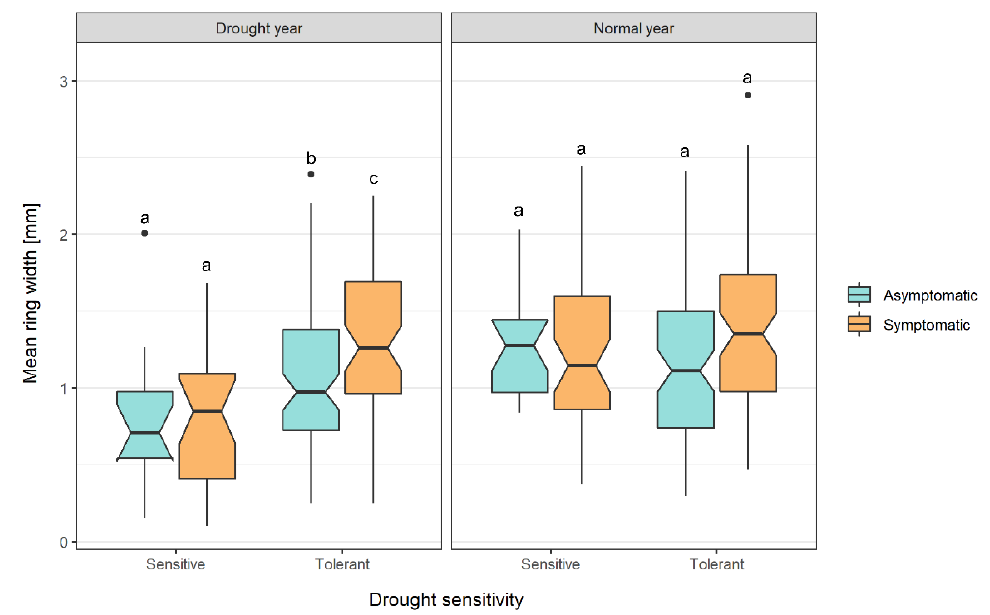
Figure 3. Boxplots of the mean ring width [mm] in climatic drought and normal years preceding the symptomatic expression according to drought sensitivity (drought-tolerant and drought-sensitive) and the symptomatic response of the specimens (asymptomatic and FDp-free (cyan) or symptomatic and FDp-infected (orange)). The letters indicate significant differences among the four categories per year type (Kruskal–Wallis paired test, p < 0.05); for the number of observations: see Table 2. Phloem anomalies were detected in all of the symptomatic and FDp-infected samples, while among the asymptomatic samples, only two out of twenty-six grapevines showed a slight disarrangement (Table 3). Drought sensitivity and the growing sector had no signifi- cant effect on the phloem anomalies either for the asymptomatic or for the symptomatic samples (Chi-Square test, p > Table 3. Number of samples with phloem anomalies according to the four main categories of asymptomatic drought-tolerant (A_dt), asymptomatic drought-sensitive (A_ds), symptomatic drought-tolerant (S_dt), and symptomatic drought-sensitive (S_ds) and the growing sector along the slope (top, slope, and toeslope). N: number of analysed samples per category and sector. Category